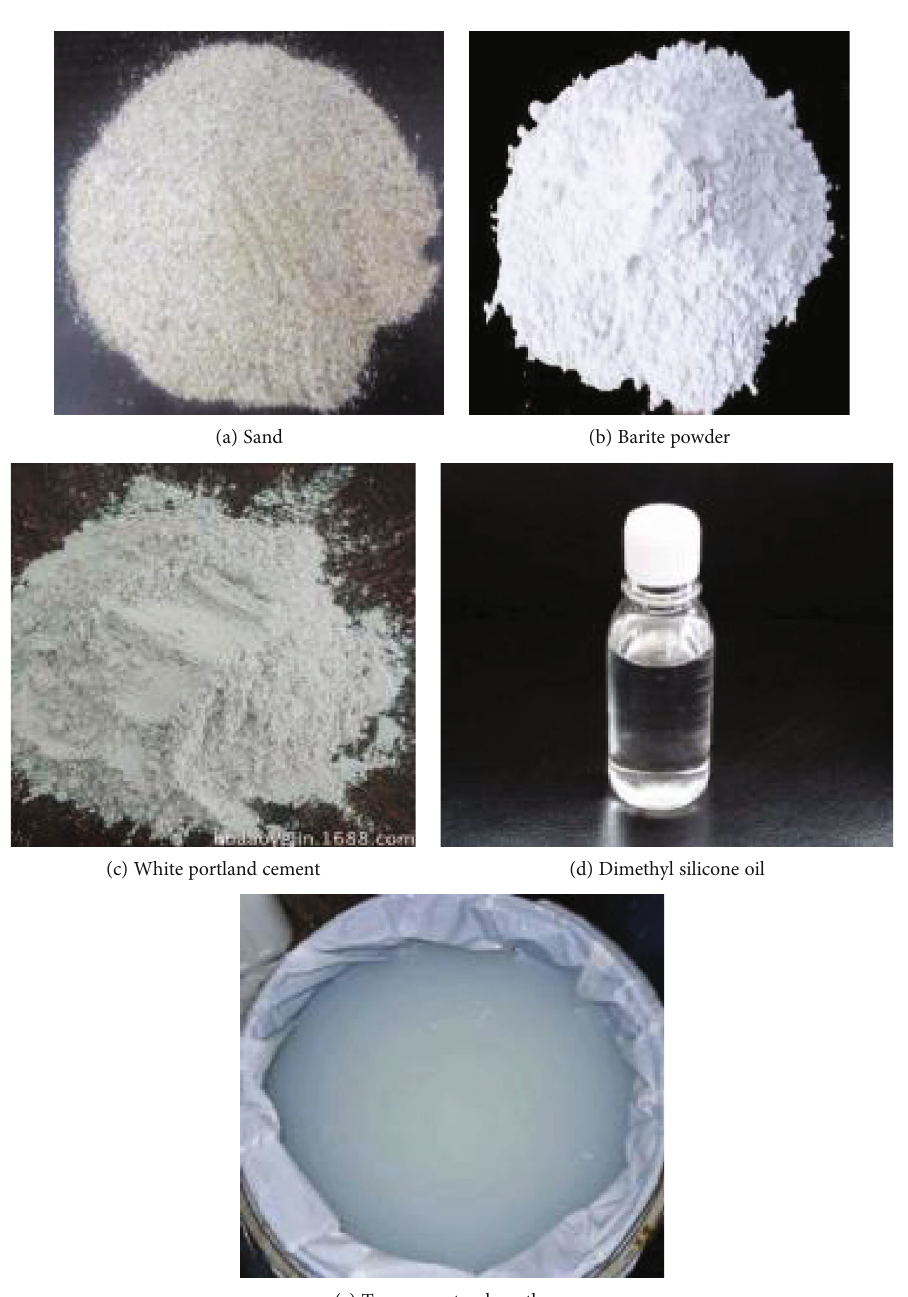
Figure 1: Raw similar materials.